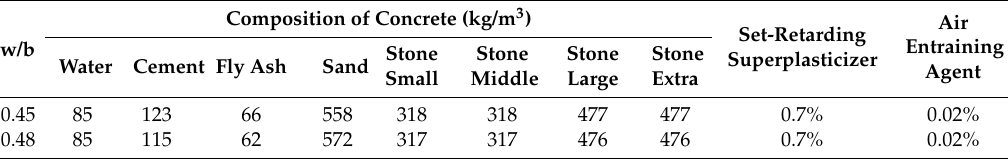
Table 1. Component mass of fly ash concrete samples with varying water-binder ratios.